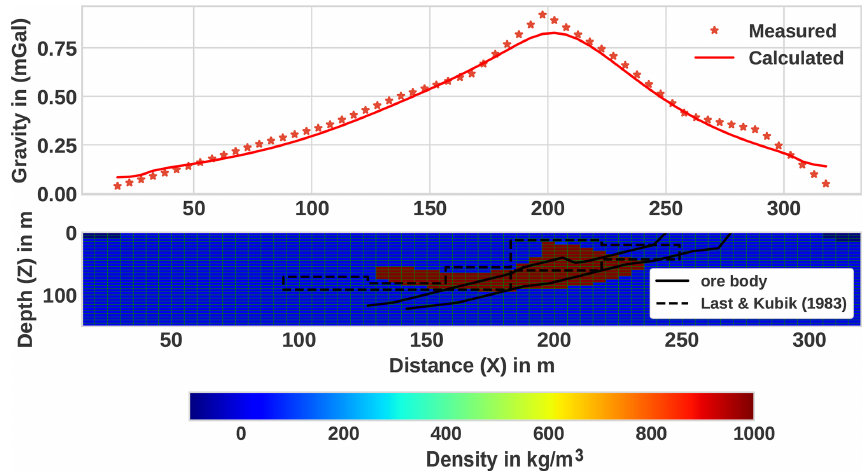
Figure 13. An observed gravity anomaly over the Woodlawn ore body, New South Wales (after Last and Kubik, 1983), and its inversion result. The digitized data (star marks) are shown together with calculated data (solid line) on the top panel. The corresponding recovered density contrast model after the 11th iteration is shown on the bottom panel, and the ore body proved by drilling is shown with the solid line. The recovered body density contrast is represented by the color scale